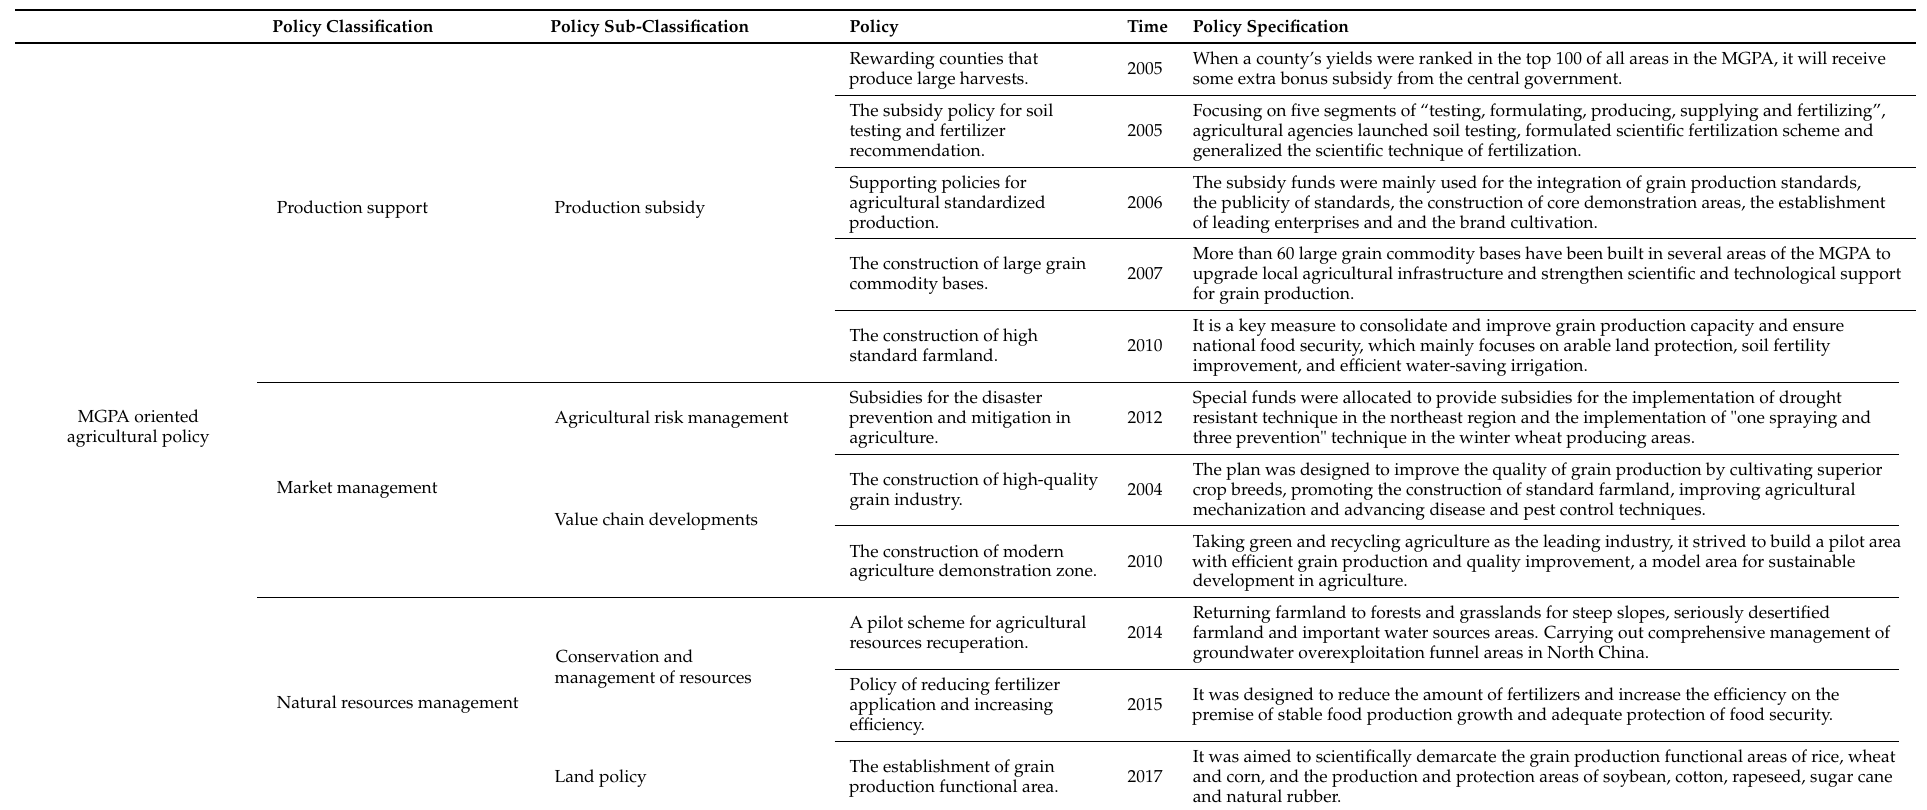
Table 1. The brief summary of the MGPA oriented